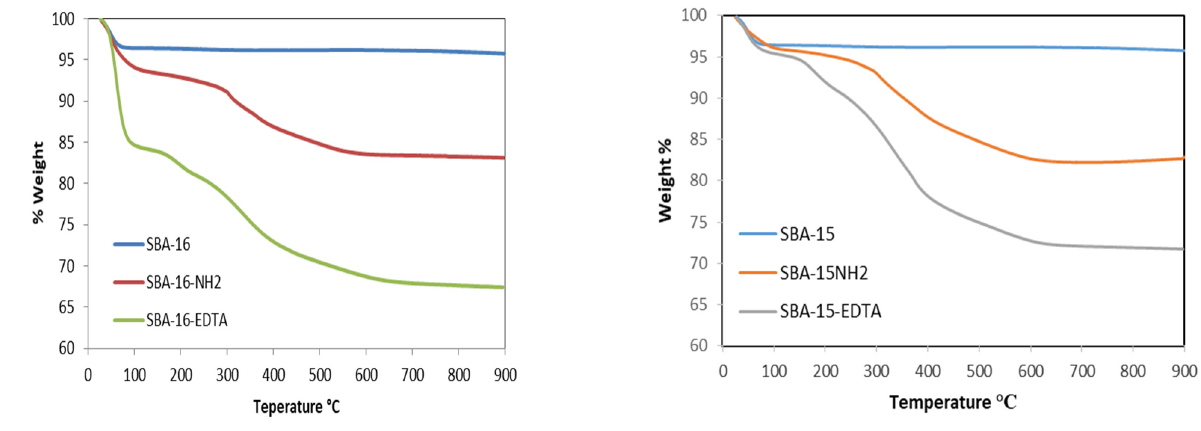
Figure 6. Thermogravimetric curves for SBA-16 and SBA-15 before and after modification.